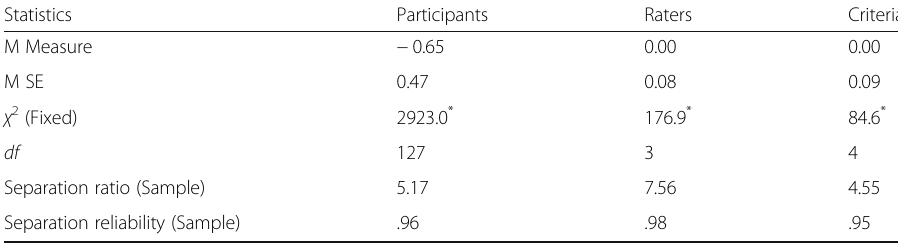
Table 4 Summary statistics for the MFRM analysis of the revised 5-point rating scales